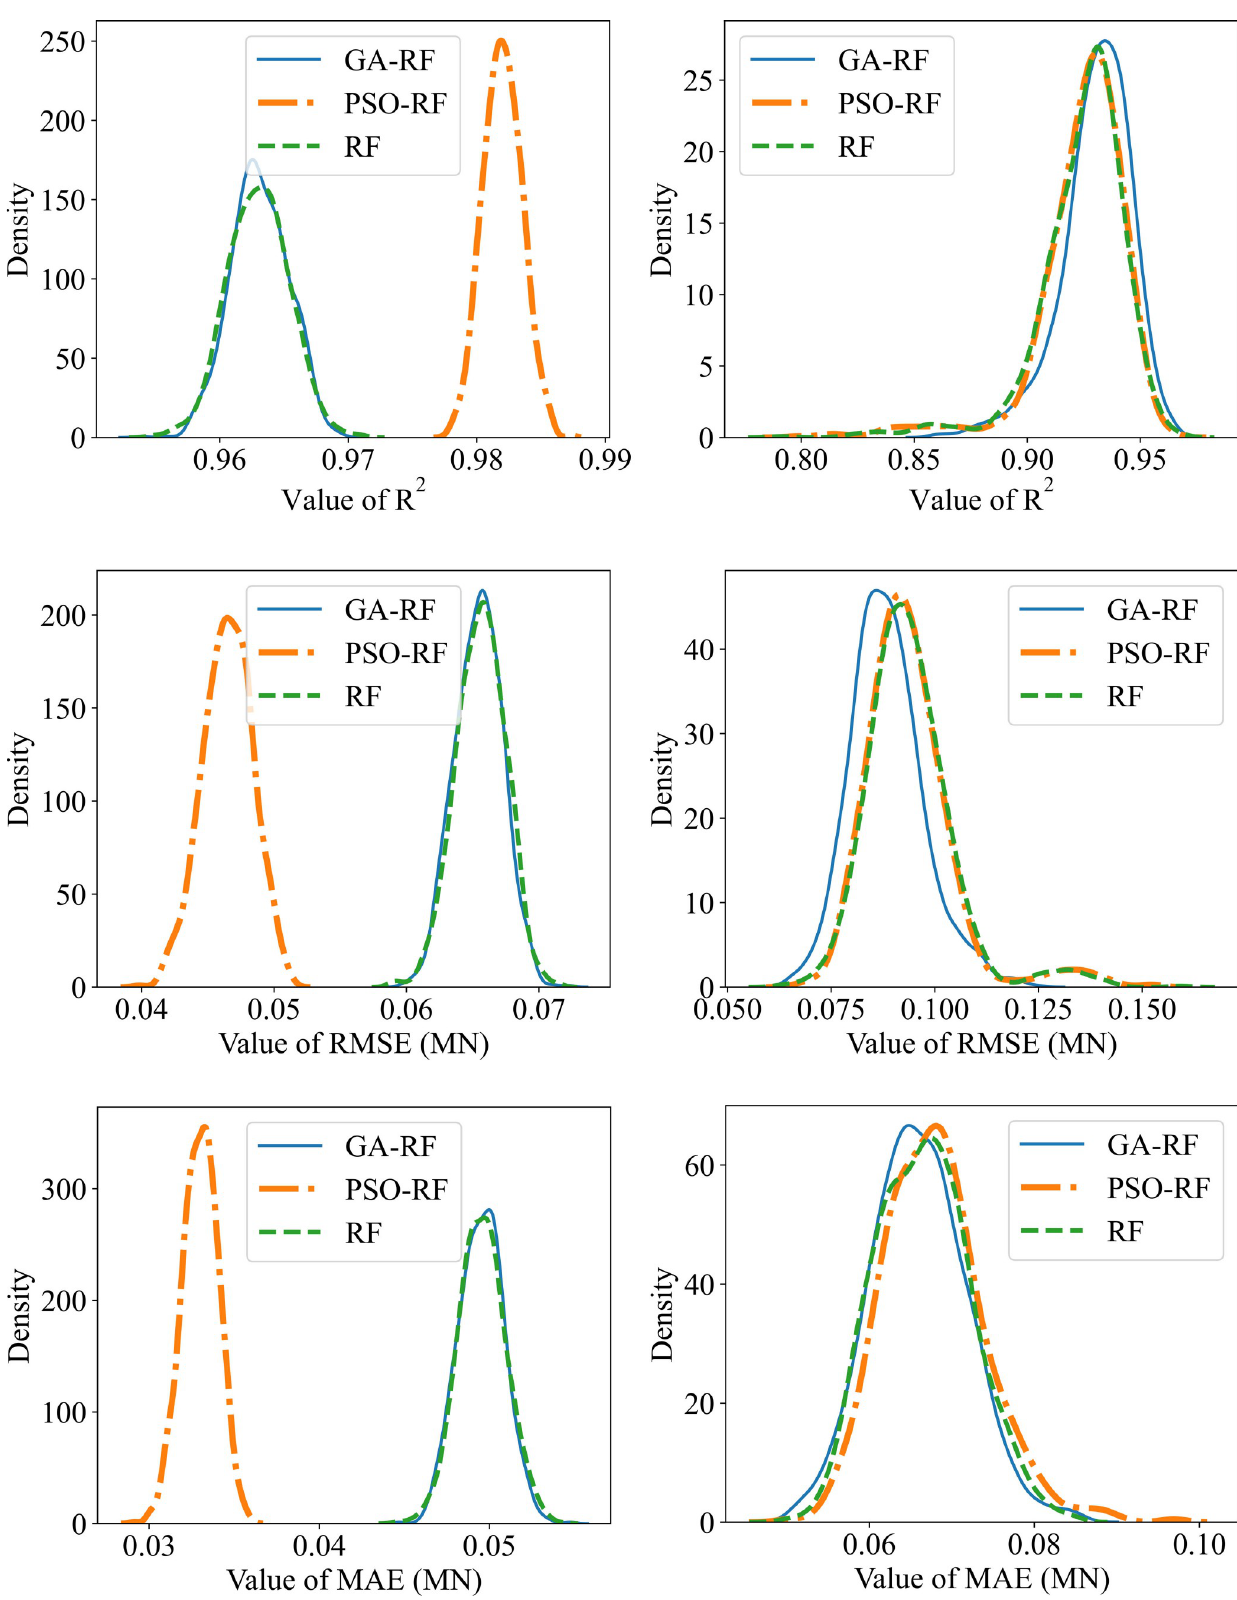
Fig 10. Density chart of models after 1000 runs for data set: (a) (c) (e)–training set; (b) (d) (f)–testing set.